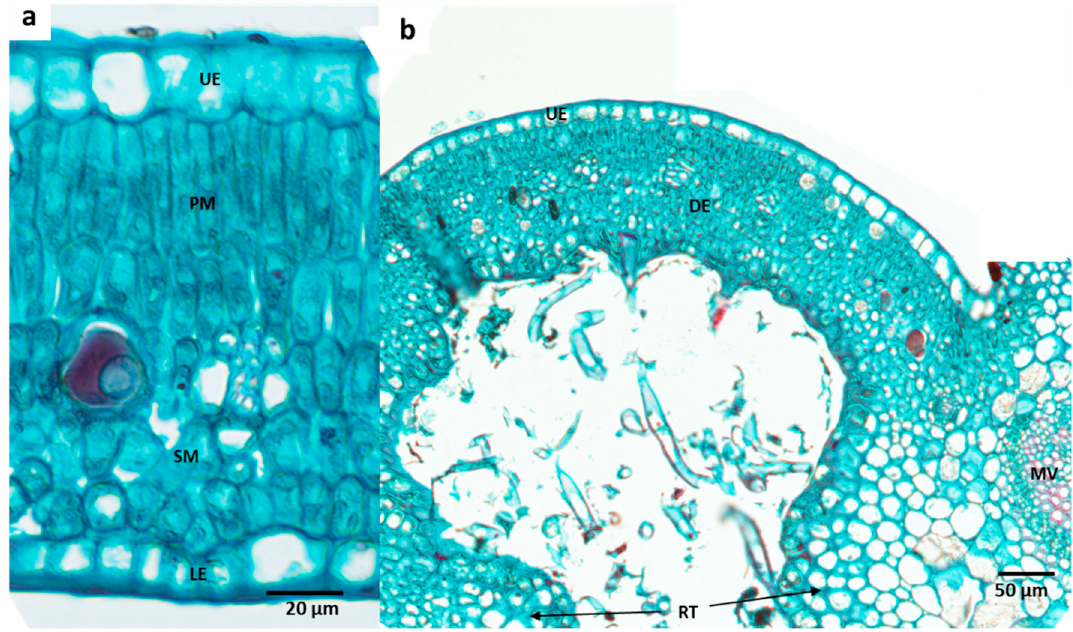
Figure 3. Comparison of non-domatial with domatial tissue of the pouch-type domatia of Gardenia thunbergia ; ( a ) non-domatial area, ( b ) domatial tissue with trichomes. LD: leaf domatial tissue, LE: lower epidermis, MV: mid-vein, UE: upper epidermis, PM: palisade mesophyll layer, RT: rim tissue, SM: spongy mesophyll layer, and T: trichomes.